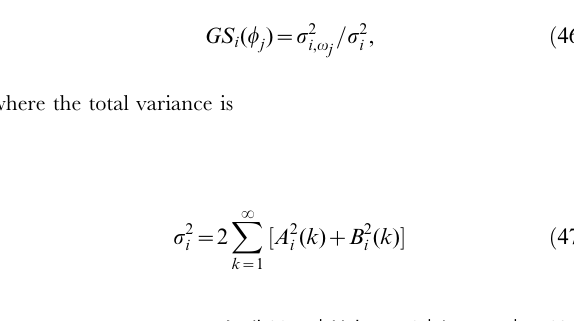
Figure 5. Comparison of original model and reduced model. The difference between the two models occurs in the transition process before the first 200 min, while the difference decreases significantly in the steady state. When ½ gal (cid:3) to both models, the steady-state deviation of the output m 1 (molec./cell) is less than 1 percent. However, the deviation of the transition process between the two models with the smaller external galactose is significant. This result is consistent with the sensitivity measure in Figure 3. The solid line is for m 1 concentration in the original model, while the open symbol is for the reduced model.